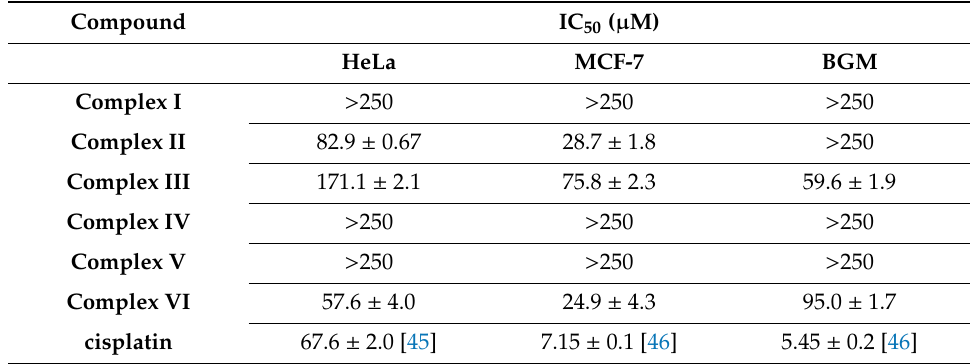
Table 4. Cytotoxicity expressed as an IC 50 mean values ( µ M) of the complexes synthesized and cisplatin (from the literature) exposed to HeLa, MCF-7 and BGM cells for 48 h.